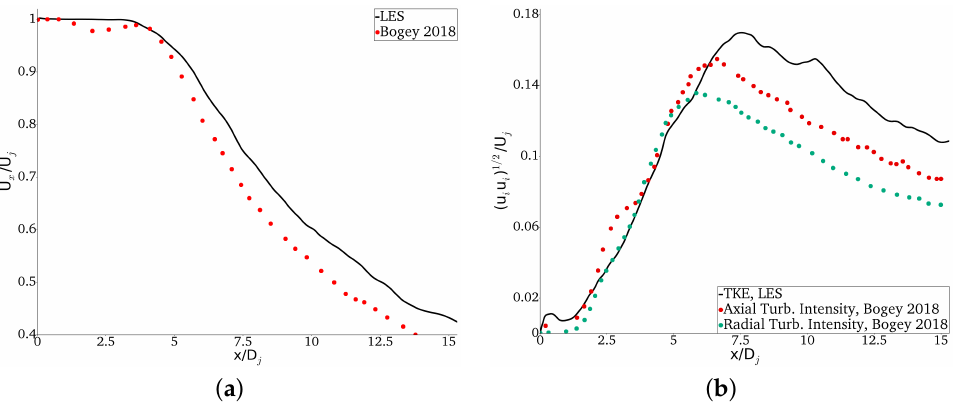
Figure 8. Centerline Jet Properties: ( a ) Mean Velocity. ( b ) Turbulence